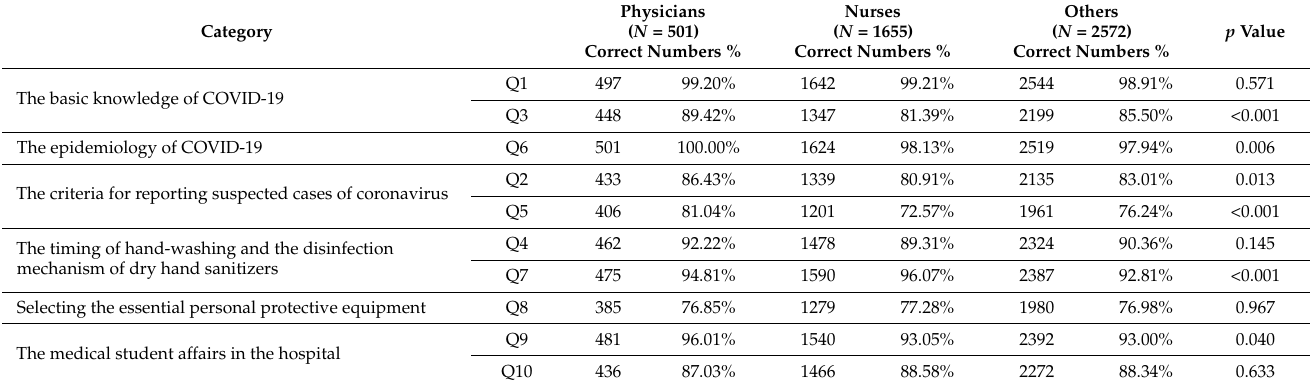
Table 4. Knowledge gaps in the ten COVID-19 multiple-choice questions of different healthcare